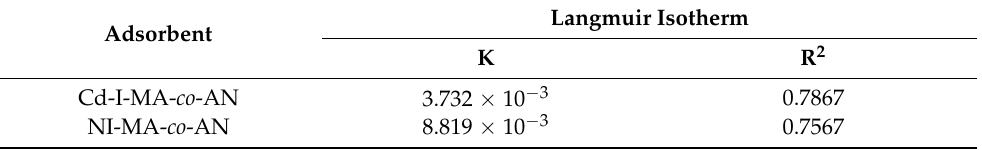
Table 2. Freundlich isotherm constants for adsorption of Cd-I-MA- co -AN and NI-MA- co -AN.